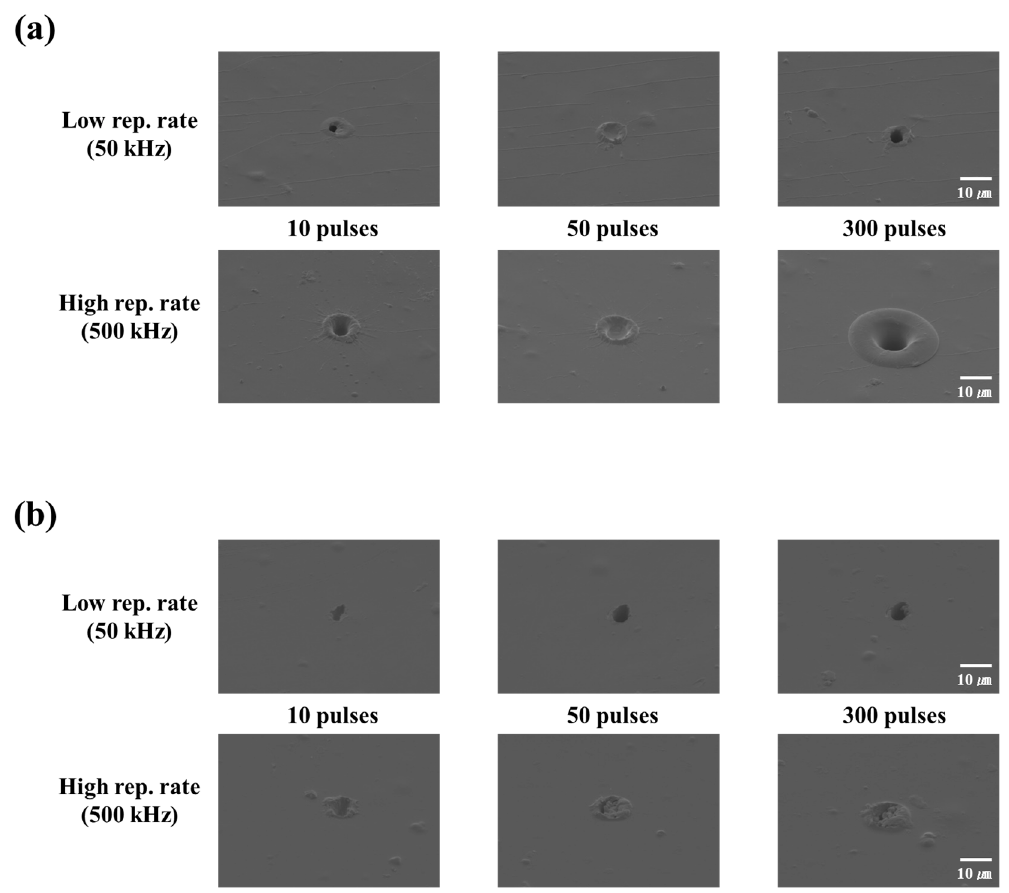
Figure 4. SEM images of the laser processing results under stationary beam irradiation with the same pulse energy (0.8 µ J; 70 J / cm 2 ). ( a ) Polyethylene terephthalate (PET) and ( b ) polyimide (PI).